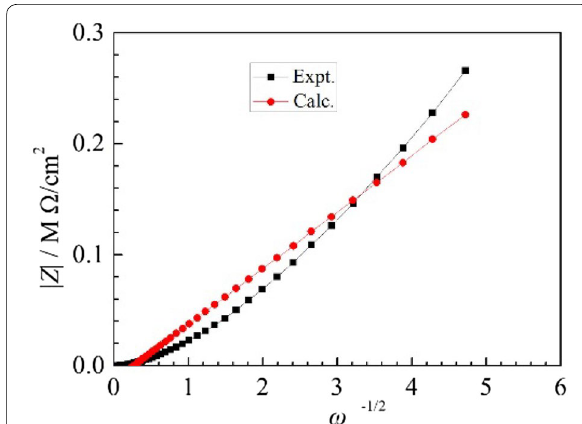
Figure 10 Fitting and experimental plots after corrected for the 304 stainless steels in borate buffer